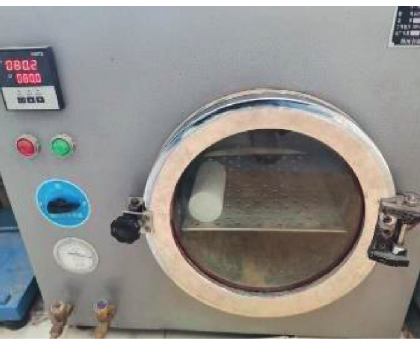
Figure 11: Heating of specimens covered by the